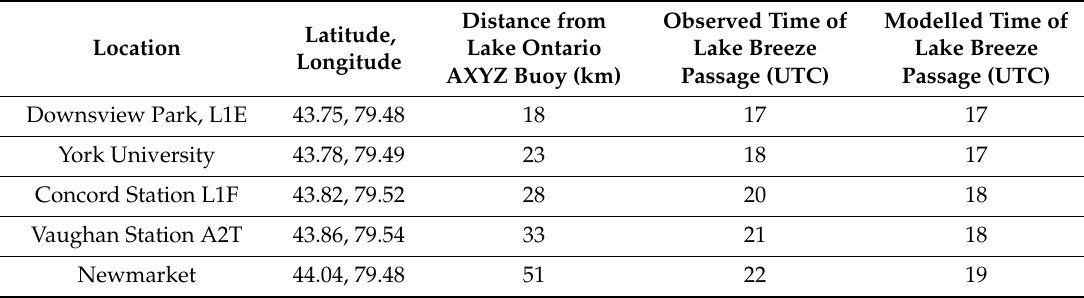
Table 4. Modelled and measured time of lake-breeze passage for locations north of Toronto on 12 July